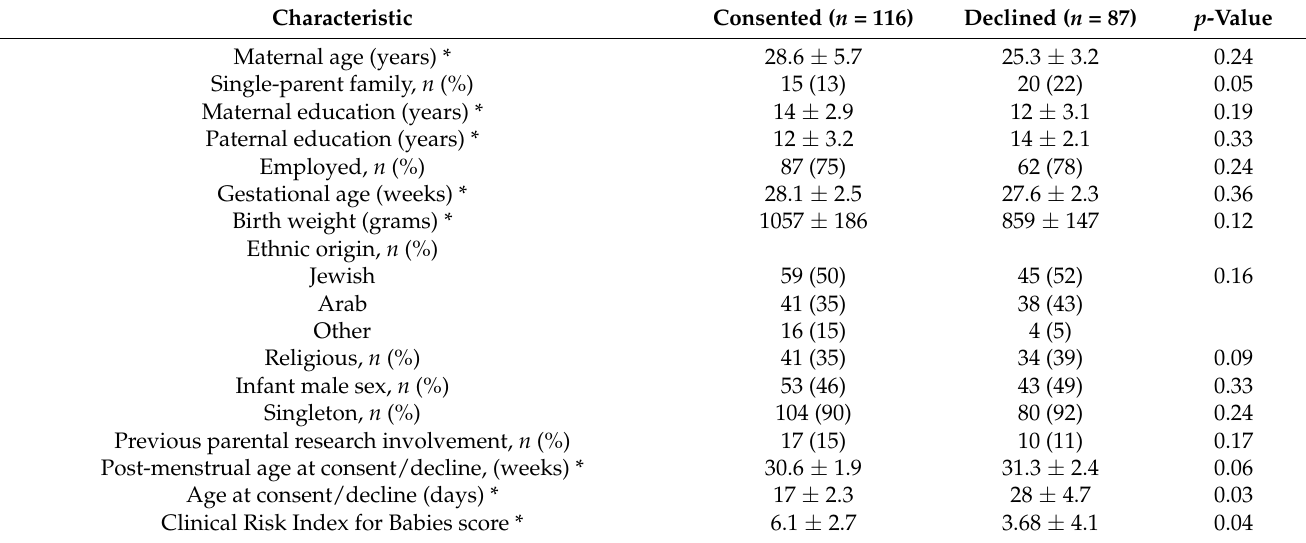
Table 3. Characteristics of those who consented or declined to participate in music intervention studies.